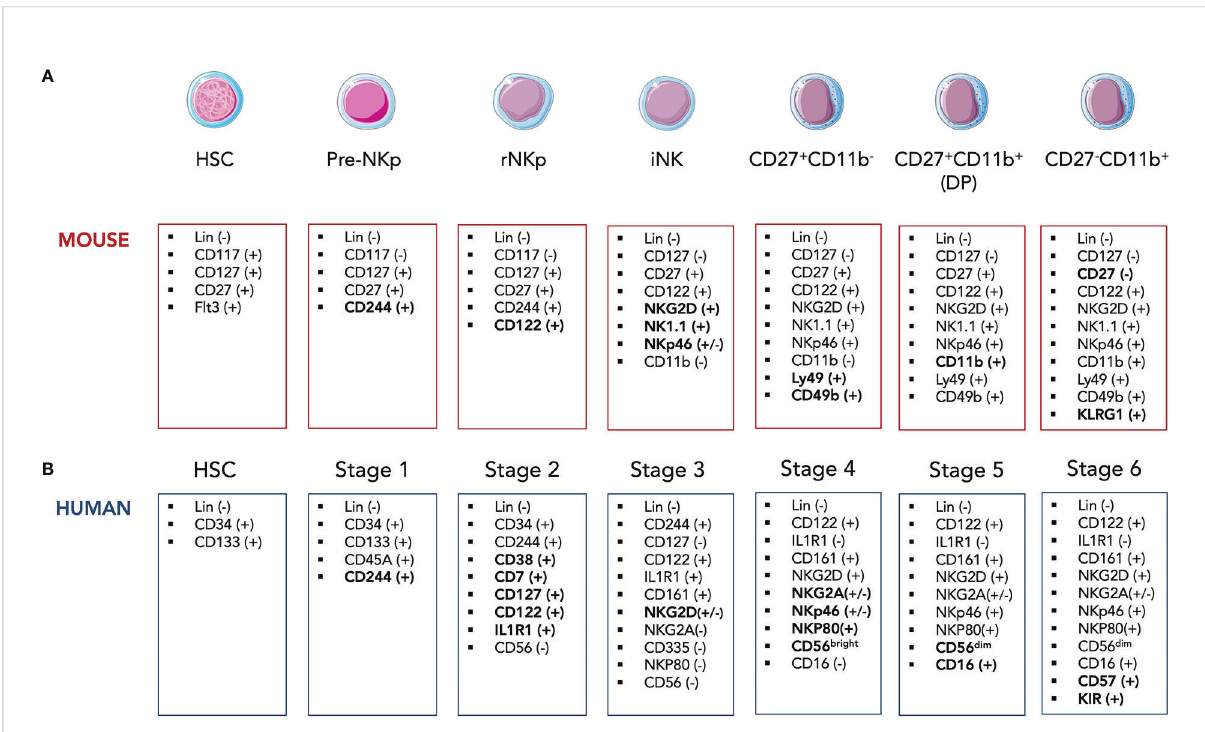
FIGURE 1 Simpli fi ed model of developmental stages of murine (A) and human (B) NK cells in the bone marrow. HSC, hematopoietic stem cell; CLP, common lymphoid progenitor; rNKp, re fi ned NK progenitor; iNK, imature NK